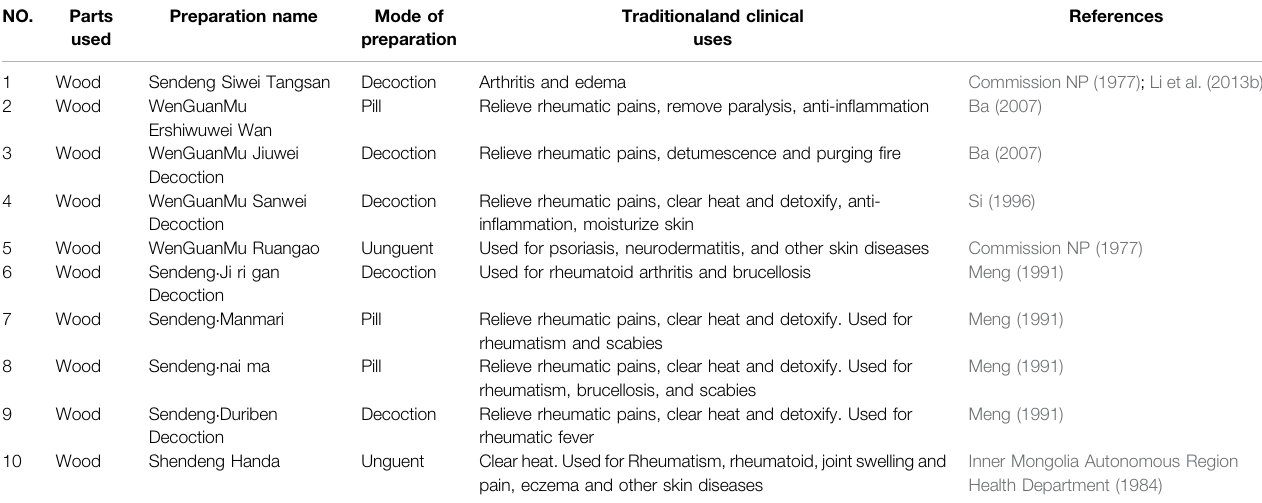
TABLE 3 | Traditional and modern prescriptions of lignum xanthocerais in China.